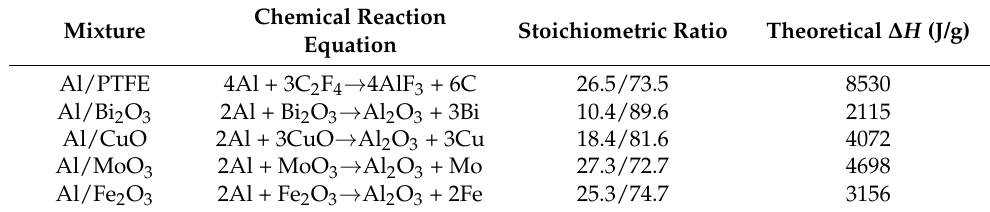
Table 1. Summary of chemical reaction information for mixtures